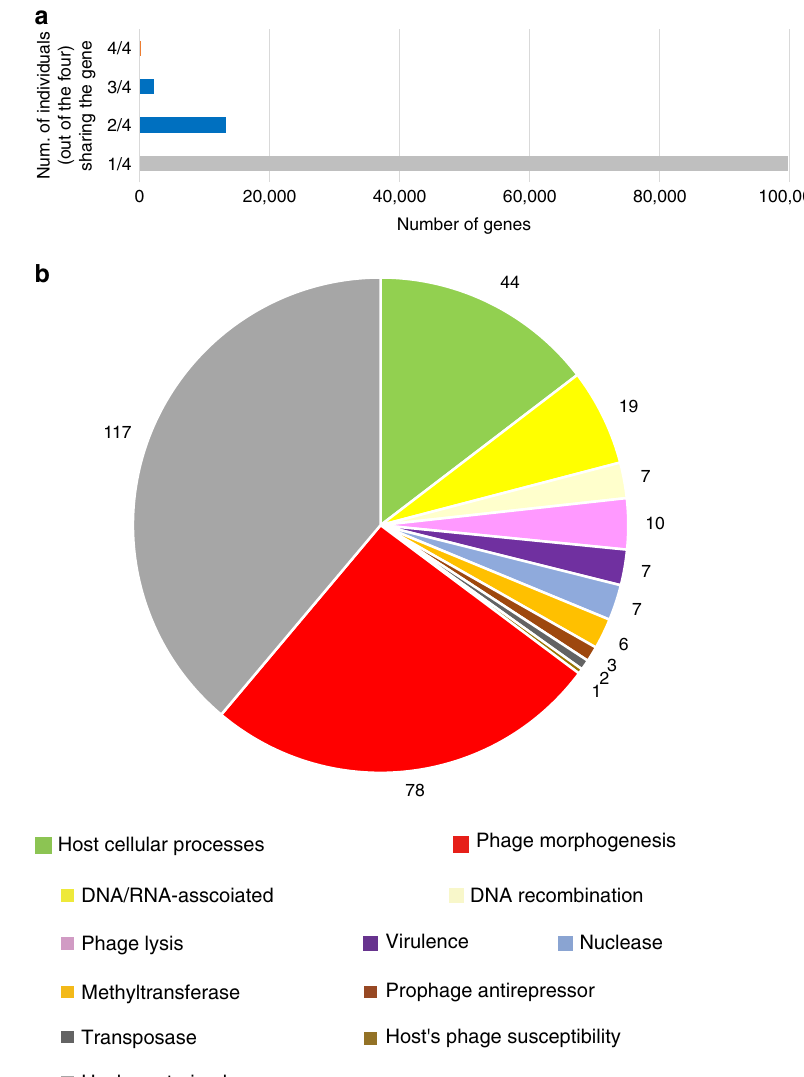
Fig. 4 Characteristics of genes encoded in oral phages/prophages. a The number of the gene present in all, three, two, and one out of the four samples. The core (4/4) genes are colored in orange, while singletons are colored in gray. b Breakdown of the core genes. The number of genes in each category is shown in the pie chart. More detailed information on each gene is shown in Table